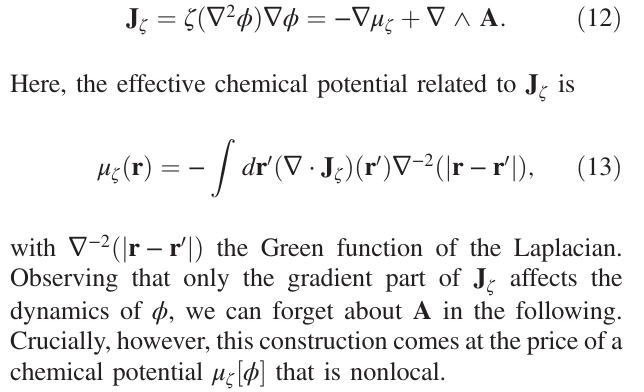
FIG. 3. Stationary values of the density for a spherical dense droplet in a dilute environment in the mean-field approximation ( D ¼ 0 ). We plot in (a) the outer density ϕ − ð R Þ and in (b) the inner density ϕ ð R Þ as a function of droplet radius R for two þ different sets of activity parameters: ζ ¼ − 1 and λ ¼ 0 . 5 [red, corresponding to region A of Fig. 4(a)] and ζ ¼ − 4 and λ ¼ − 1 [blue, corresponding to region B of Fig. 4(a)]. Points indicate results from the numerical simulations, and lines indicate analytical results. When the pseudosurface tension σ is positive (red line), ϕ ð R Þ are both decreasing functions of R . Instead, (cid:3) when σ < 0 (blue line), ϕ − ð R Þ is increases when R